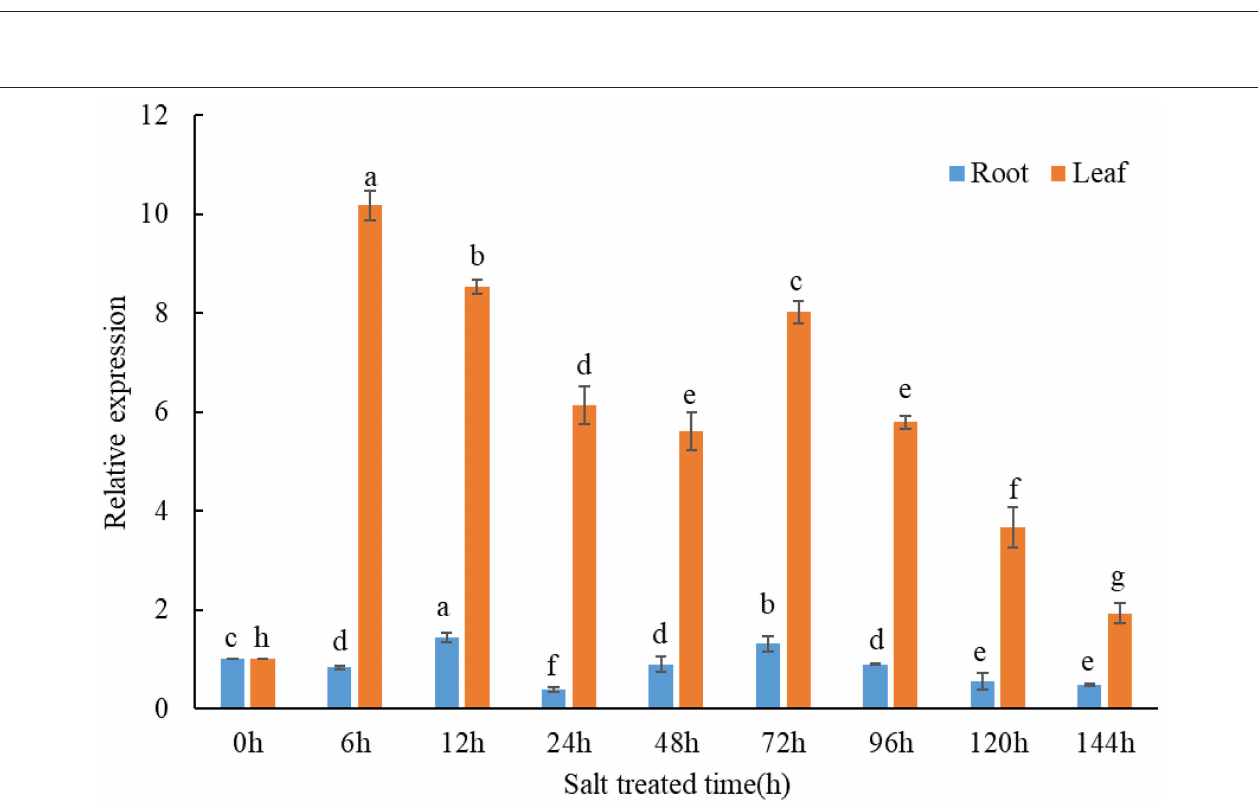
FIGURE 2 | Transcript levels of TaMCA-Id in roots and leaves of wheat seedlings under NaCl treatment using qPCR assay. Data are presented as mean ± SD from at least three independent experiments. Bars with different letters are significantly different at P < 0.05.